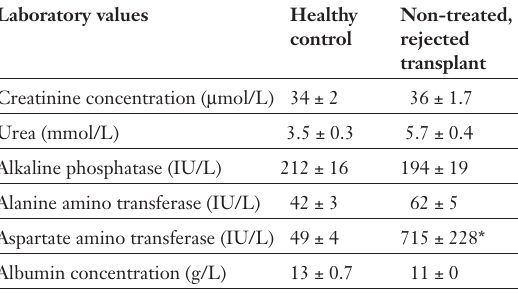
Biochemical charac-